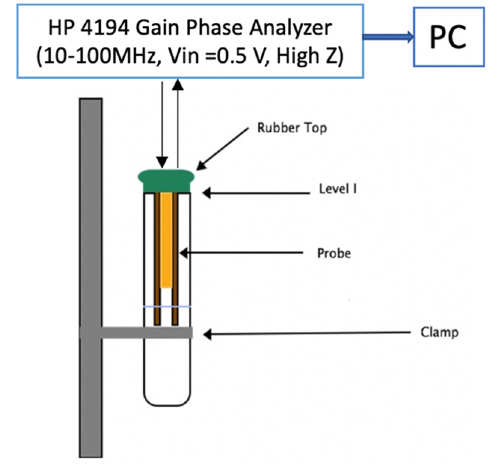
Figure 3. Experimental setup.